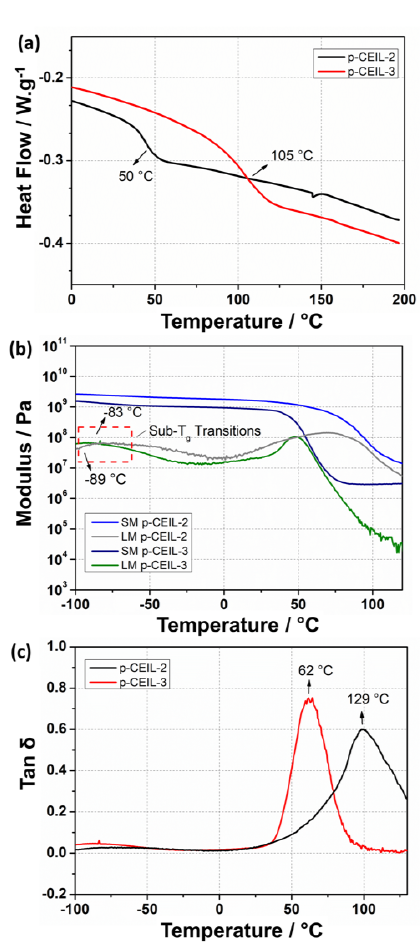
Figure 8. ( a ) DSC thermograms obtained for the epoxy networks based on p-CEIL-2 and p-CEIL-3. ( b ) DMA graph for p-CEIL-2 epoxy network displaying the T g range from 116 to 140 ◦ C. ( c ) DMA graph for p-CEIL-3 epoxy network displaying the T g range from 50 to 80 ◦ C. SM and LM correspond to the storage modulus and loss modulus,